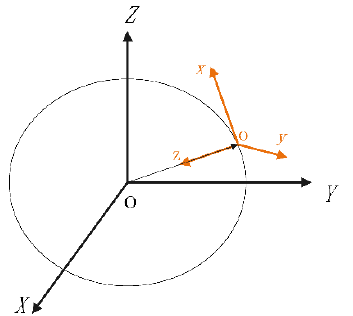
Figure 5. The target orbital frame o - xyz . ( O - XYZ is the earth-centered inertial frame. The origin of o - xyz frame is located at the satellite centroid. The oz axis points from the satellite centroid to the geo-center. The oy axis points to the negative normal direction of the orbital plane. The ox axis is along the satellite’s forward direction, forming a right-handed cartesian frame with the other two axes).